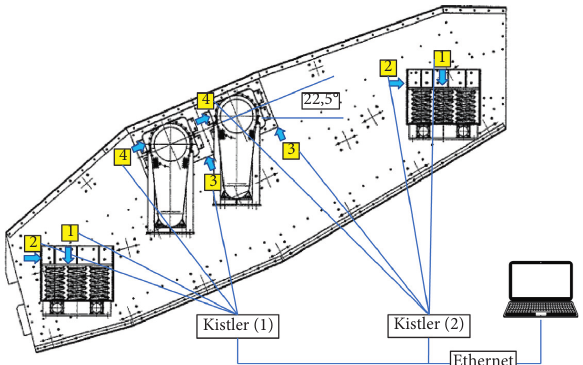
Figure 10: Places and directions of accelerometers mounting on the vibrating